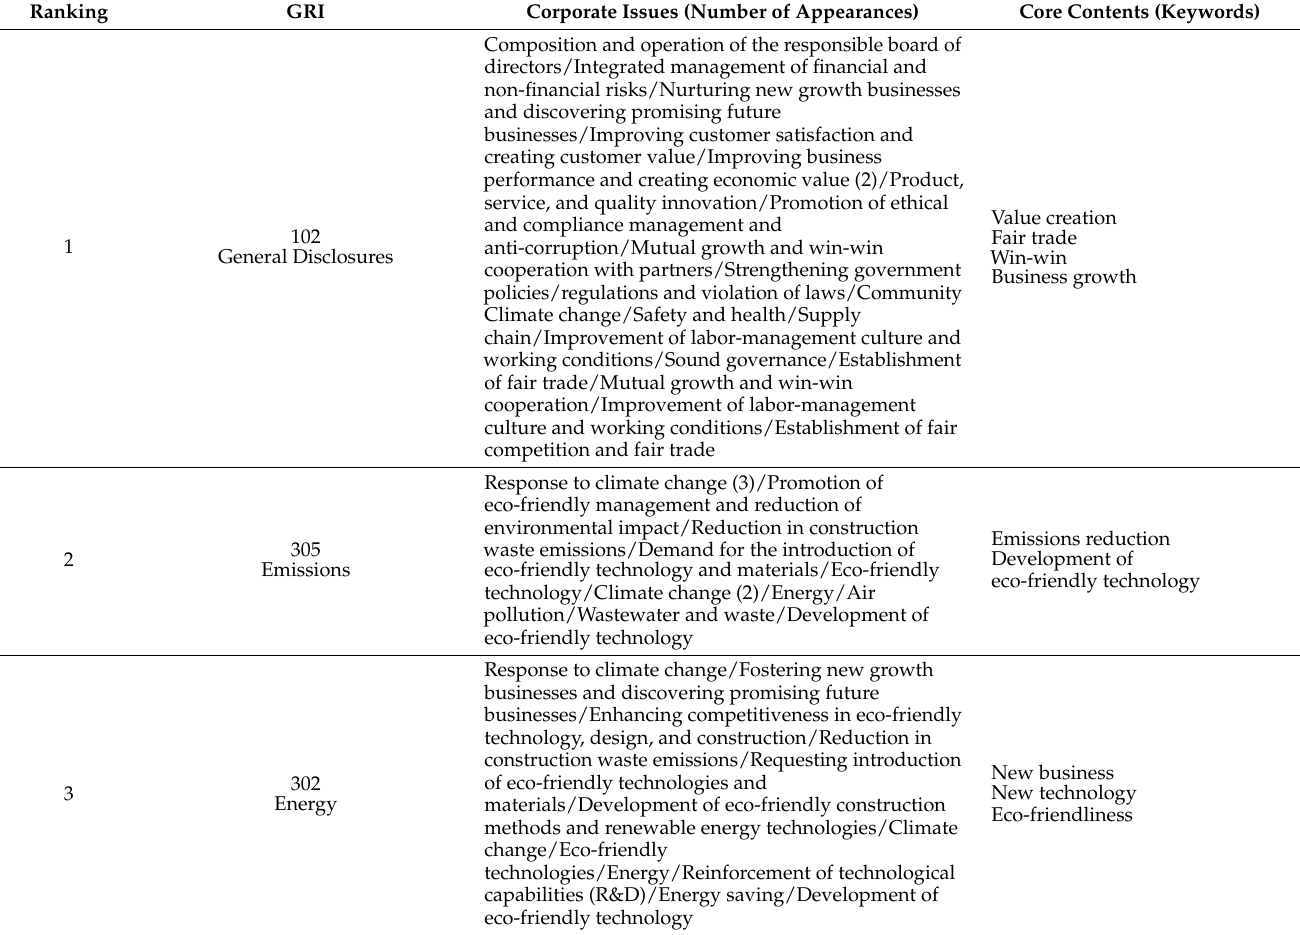
Table 10. Detailed issues and derivation of keywords from issues corresponding to the top 5 GRI codes among South Korean construction